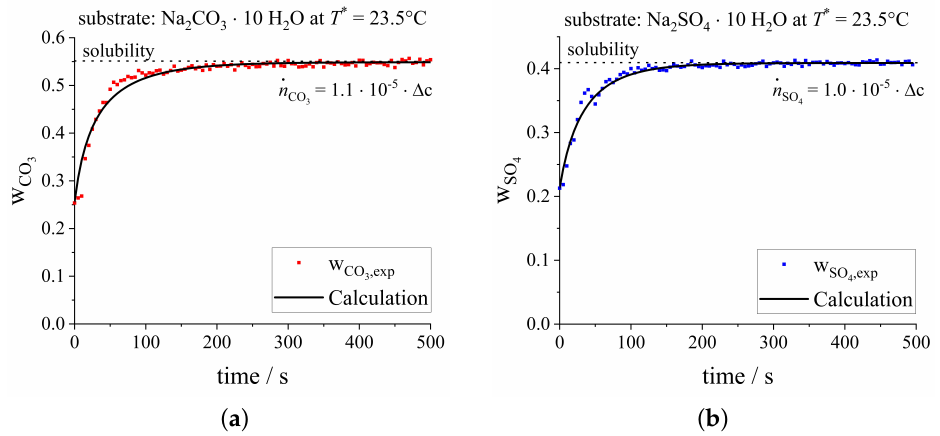
Figure 5. Diagram ( a ) displays the increase in CO 3 -loading of the solution for the dissolution of sodium carbonate decahydrate. Diagram ( b ) displays the increase in SO 4 -loading of the solution for the dissolution of sodium sulfate decahydrate. The given equations were used to calculate the solid